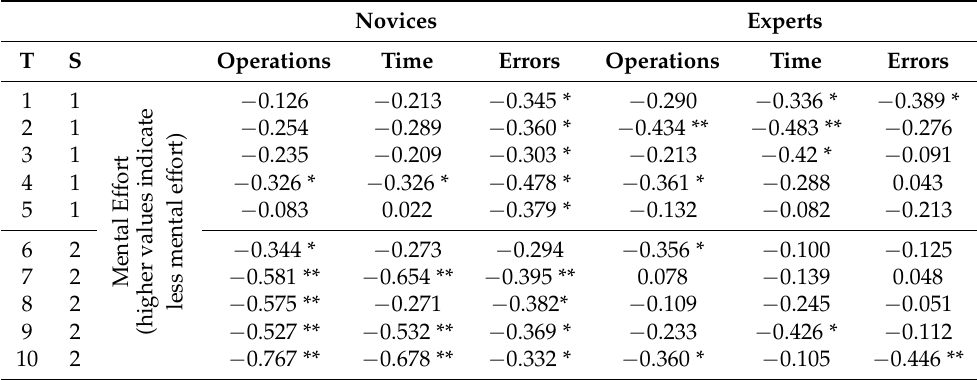
Table 4. Correlations between mental effort and performance measures for novices and experts. Novices Experts Operations Time Errors Operations Time